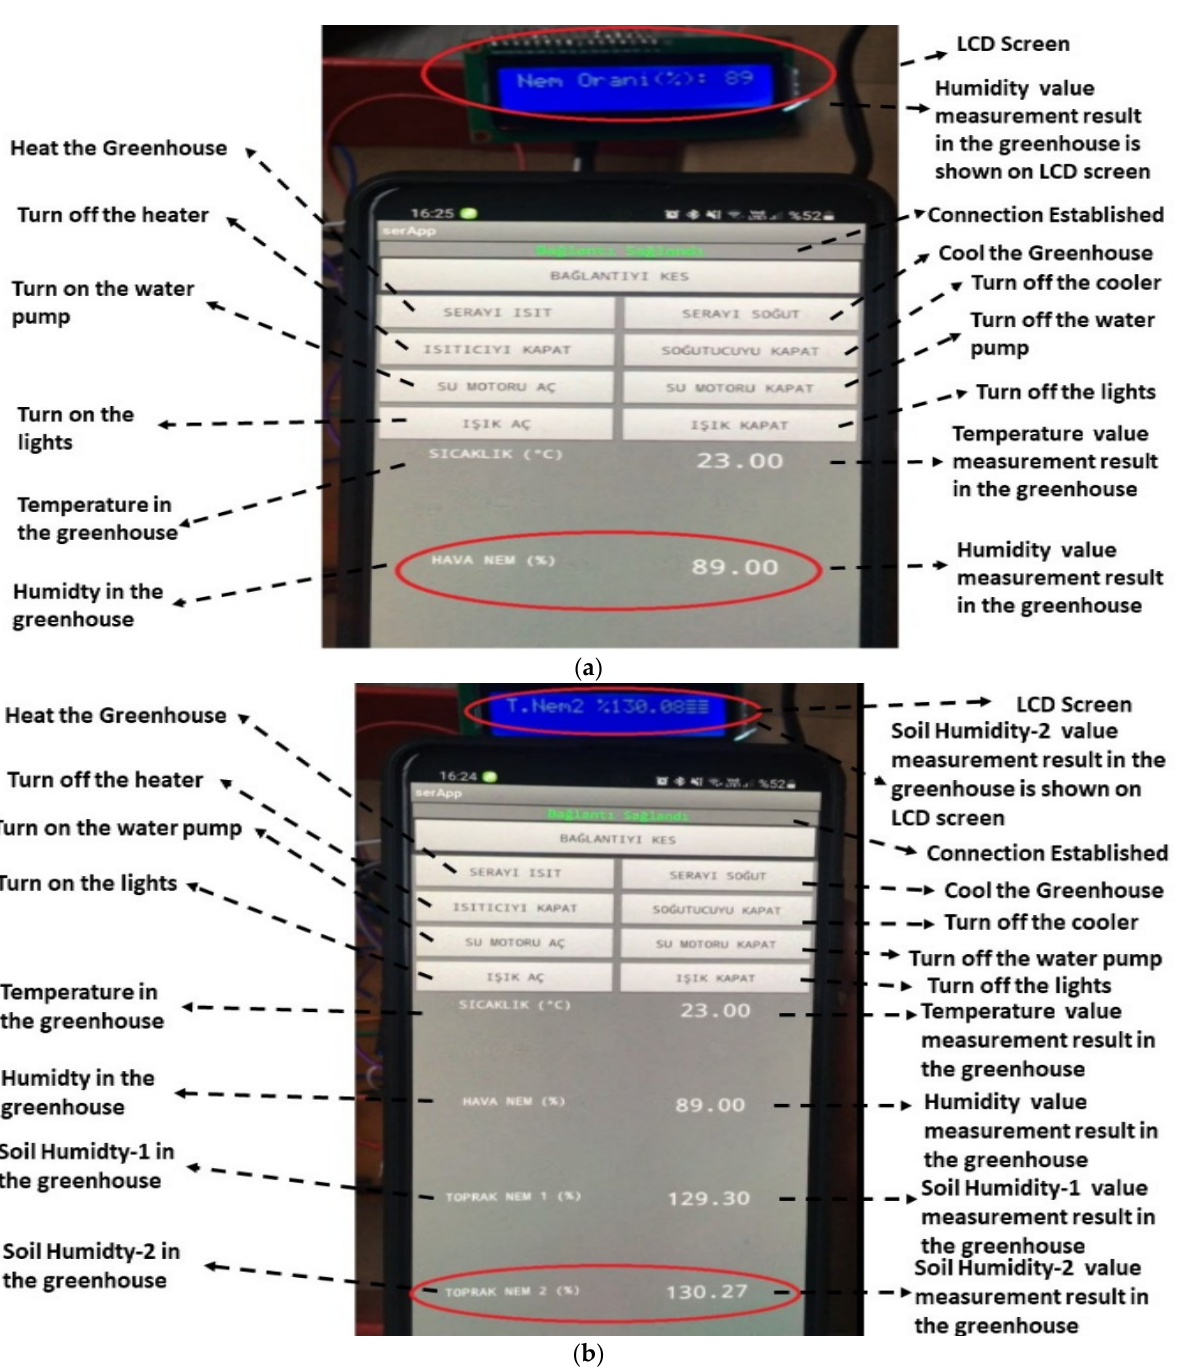
Figure 5. ( a ) Air humidity and ( b ) soil moisture 2 in the application and on the LCD